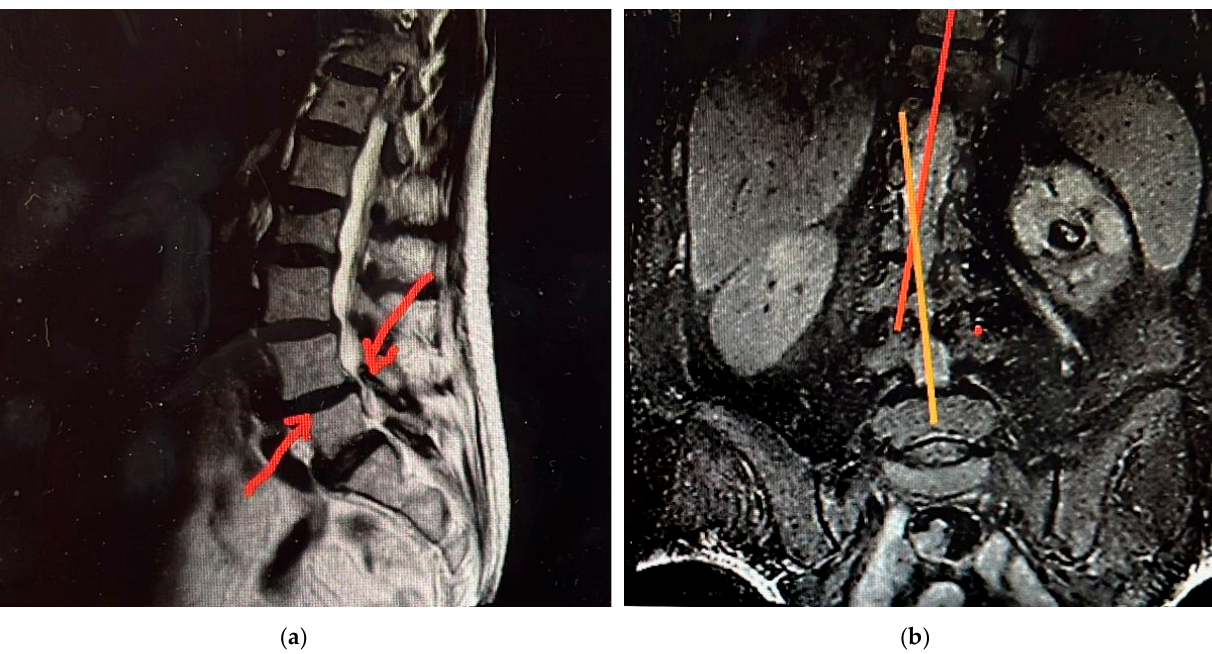
Figure 2. ( a , b ) MRI images of the spine for Case 1 following three weeks of sciatica and one week before the bilateral fracture. The inflammation and the discal prolapse associated with lumbar scoliosis remarked could have led to instant pain and caused the fall. The femoral heads are not shown in this image.